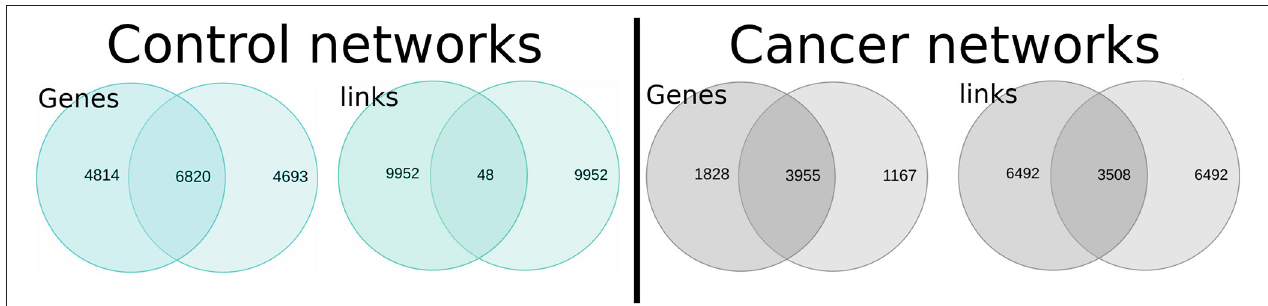
FIGURE 4 | Intersections between normal (Left) and lung cancer (Right) gene co-expression networks (GCNs). The upper section of the figure shows (in the form of Venn diagrams) the number of shared genes and interactions between NAD and NSC networks (blue diagrams); the right part represents the intersection between TAD and TSC